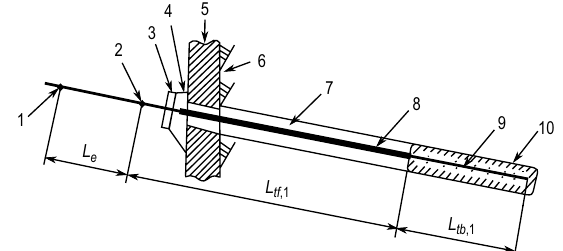
L tf ,1 L tb Fig. 2. Sketch of a ground anchor: 1– Anchorage point at jack during stressing; 2 – Anchorage point at anchor head in service; 3 – Bearing plate; 4 – Load transfer black; 5 – Structural element; 6 – Soil; 7 – Borehole; 8 – Debonding sleeve; 9 – Tendon; 10 – – Tendon free length; L – Tendon bond Grout body; L tf ,1 tb, 1 – External length of tendon length; L e